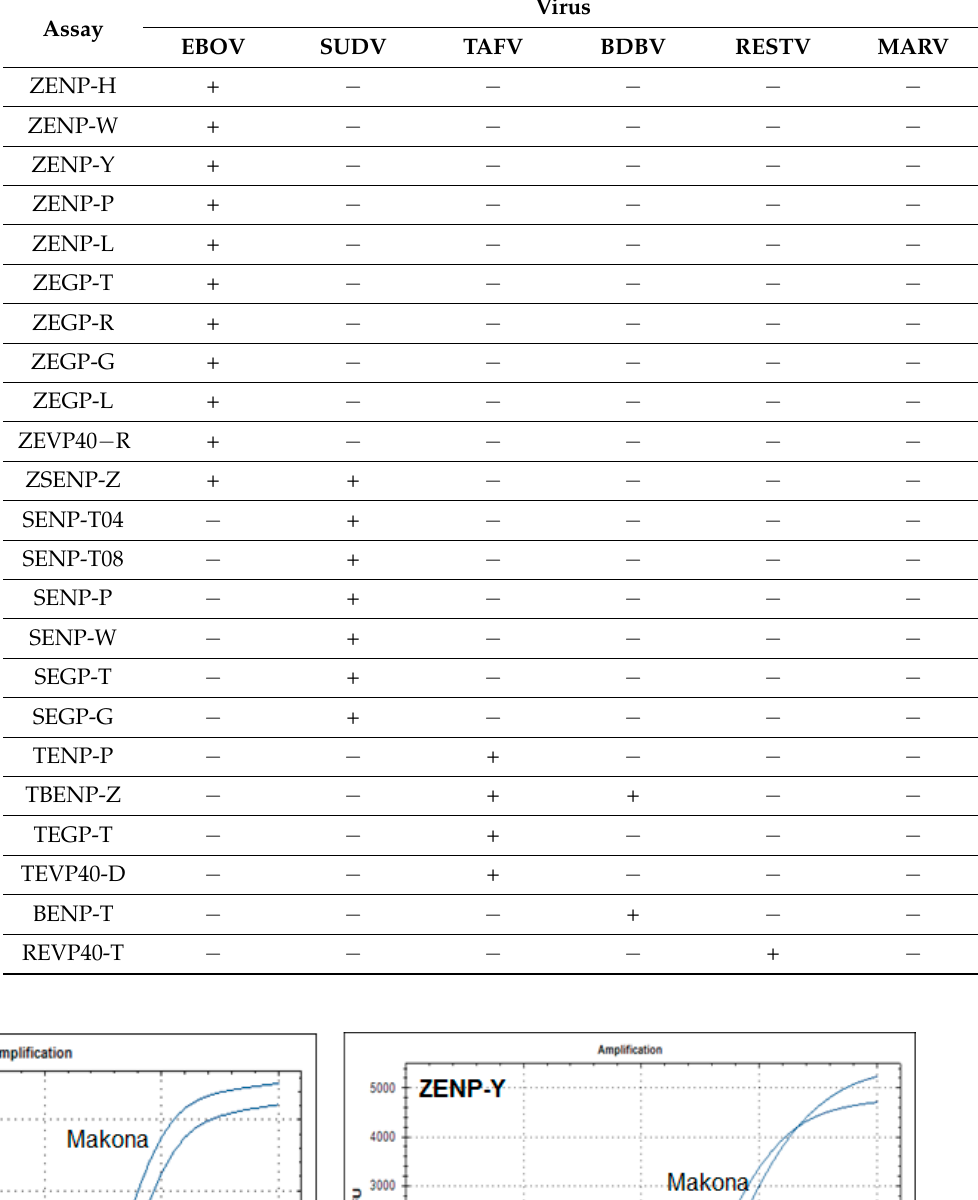
Table 5. Specificity of ebolavirus species-specific real-time one-step RT-PCR assays.